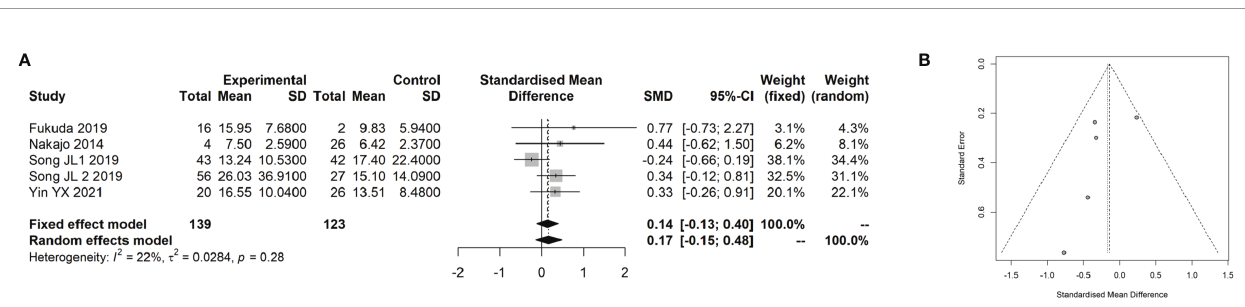
FIGURE 5 | Meta-analysis for the association of SUVmax with Ki-67 index in CRC cancer. (A) Forest plot for the association of SUVmax with Ki-67 index. (B) Funnel plot for the publication